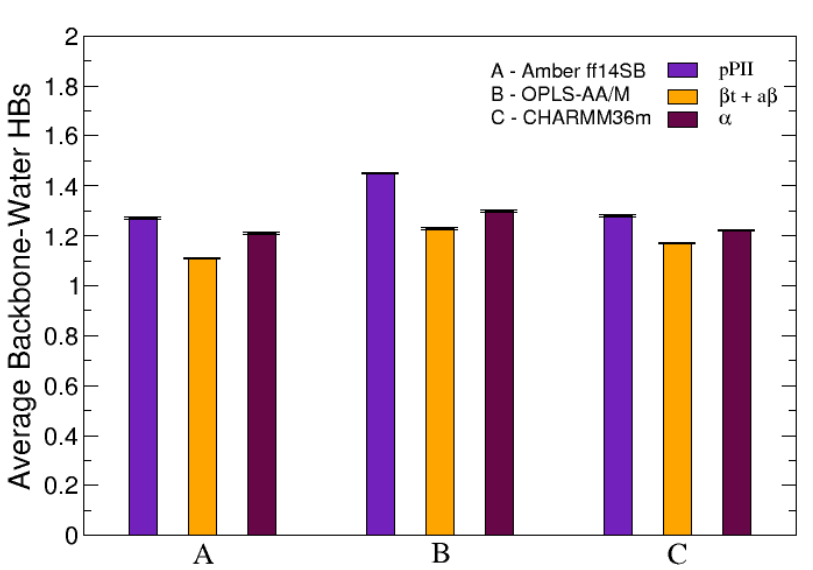
Figure 6. The average number of HBs between the functional backbone groups of the central glycine in GGG and water calculated individually for each of the three mesostates: pPII, β -strand (comprising both a β and β t as defined in Section 2.2.) and right-handed helical ( α ). The error bars correspond to the SEM